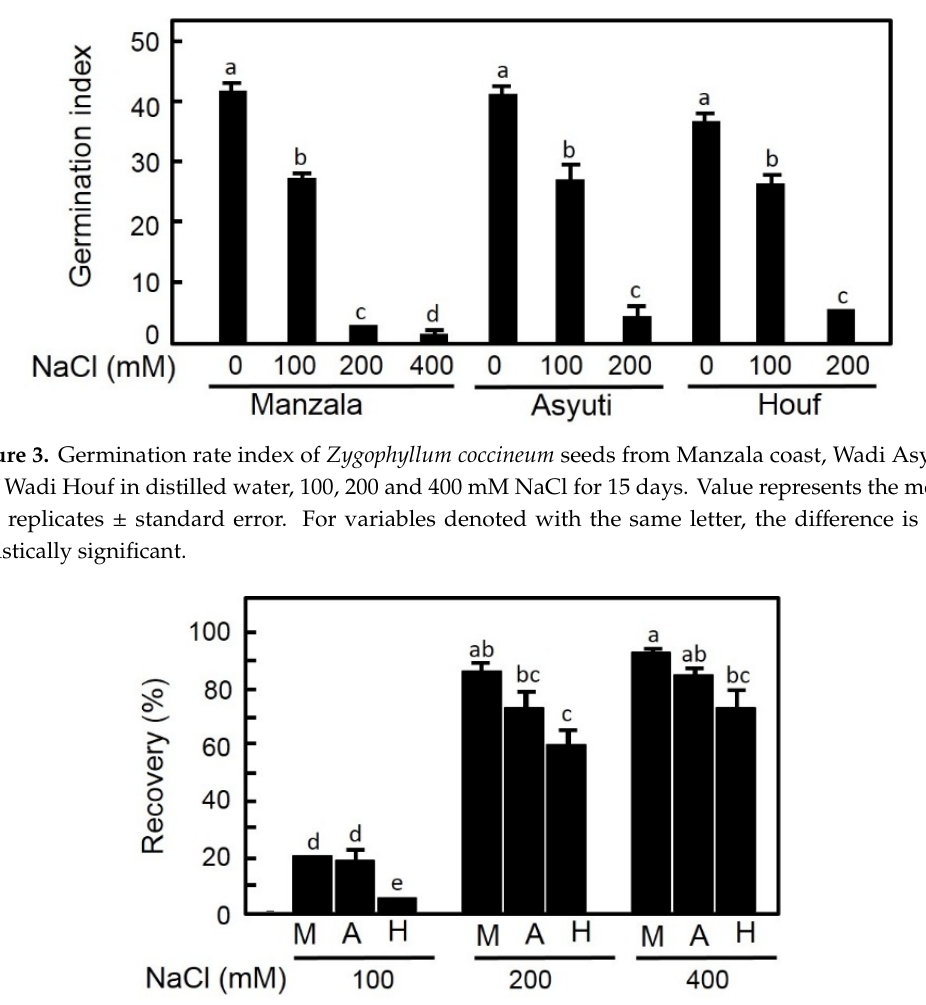
Figure 4. Germination percentages of Zygophyllum coccineum seeds recovered from 100, 200 and 400 mM NaCl for 15 days. Value represents the mean of 3 replicates ± standard error. For variables denoted with the same letter, the difference is not statistically significant.